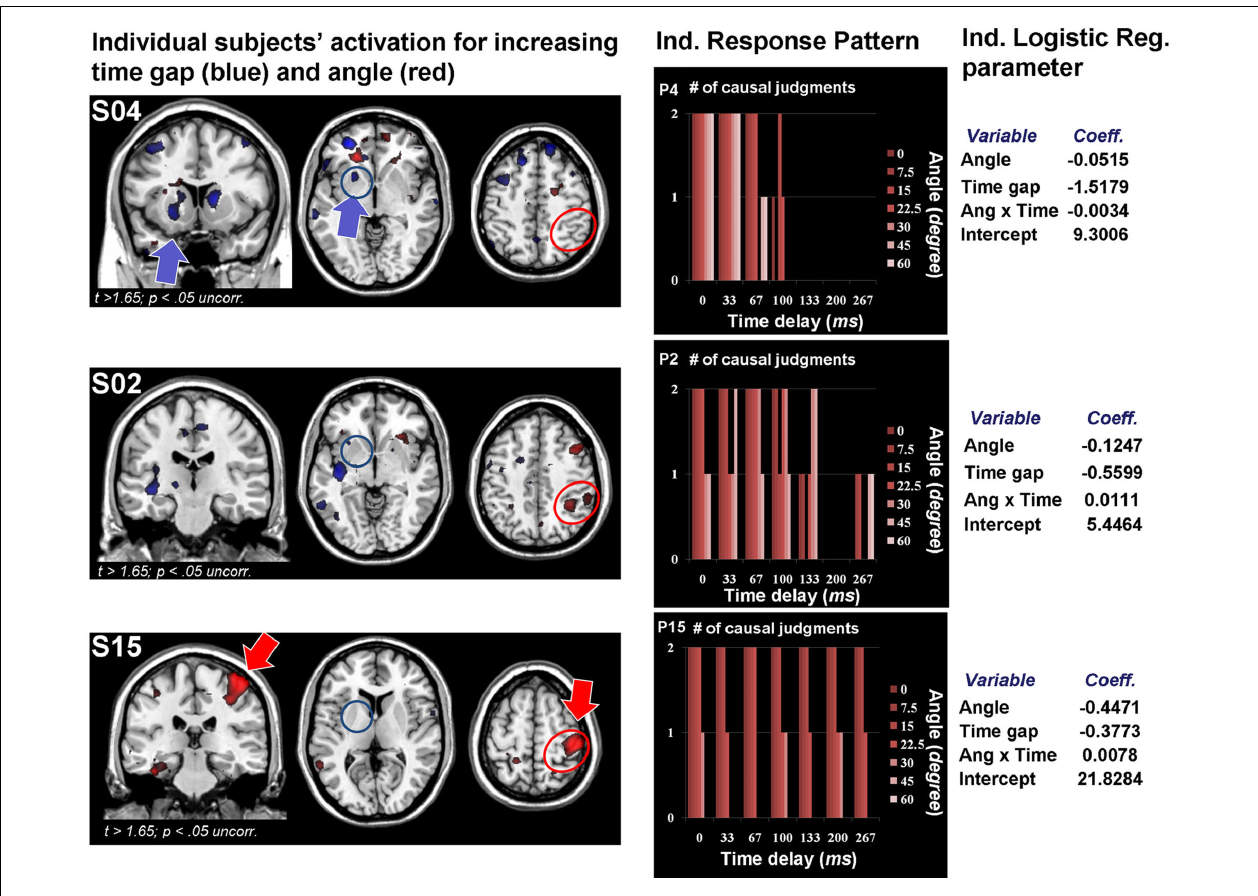
FIGURE 6 | Brain activation and causality judgments of three individual participants. Illustration of three individual participants with different patterns of brain activation in response to increasing angle (red) and time delay (blue; left). These participants also show distinct response patterns in their judgments of causality (center) and corresponding predictive values of